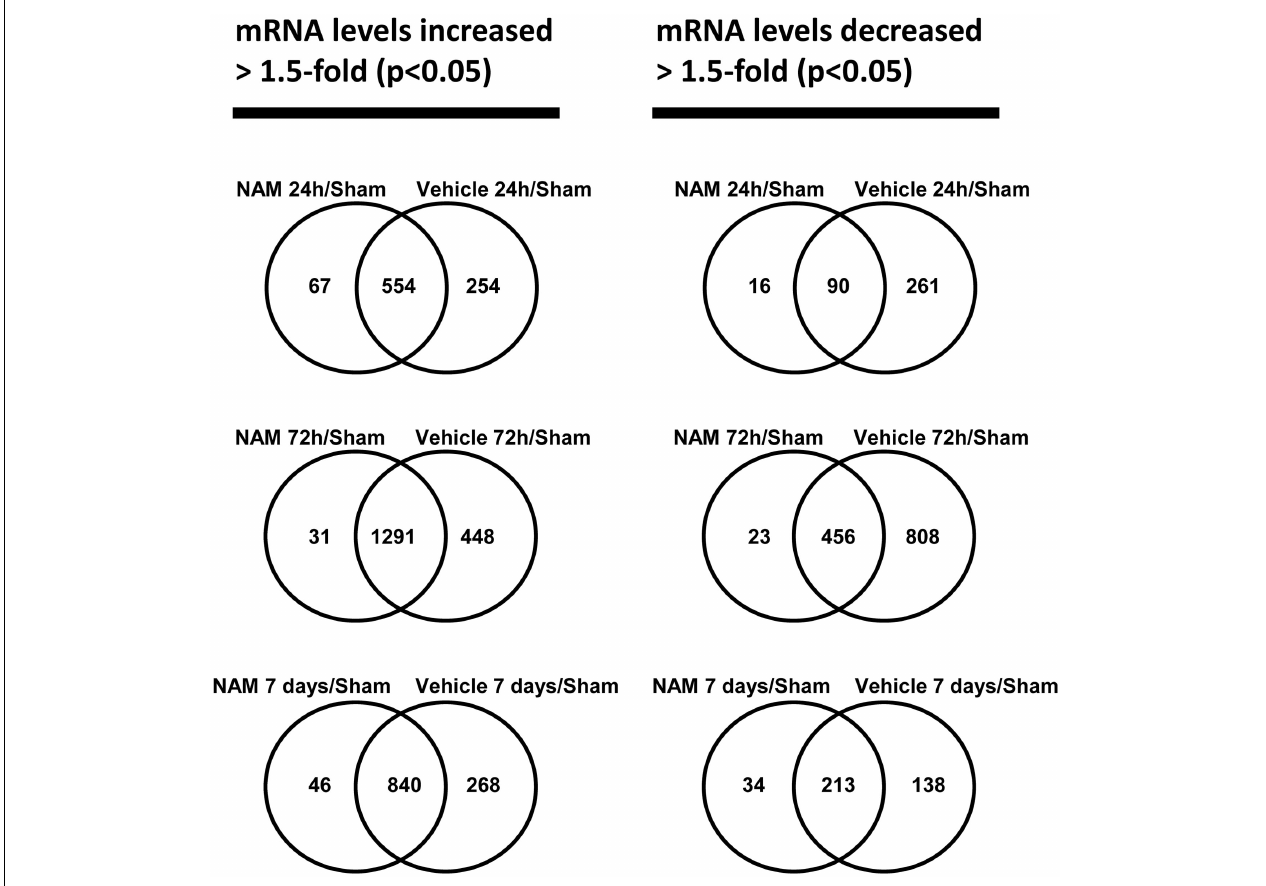
FIGURE 2 |TheVenn diagrams show the number of genes whose expression was up or down-regulated more than 1.5-fold ( p < 0.05) in the NAM/Sham andVehicle/Sham contrasts at the 24h, 72h, and 7-day time points. Venn diagrams were generated with the Bioconductor limma